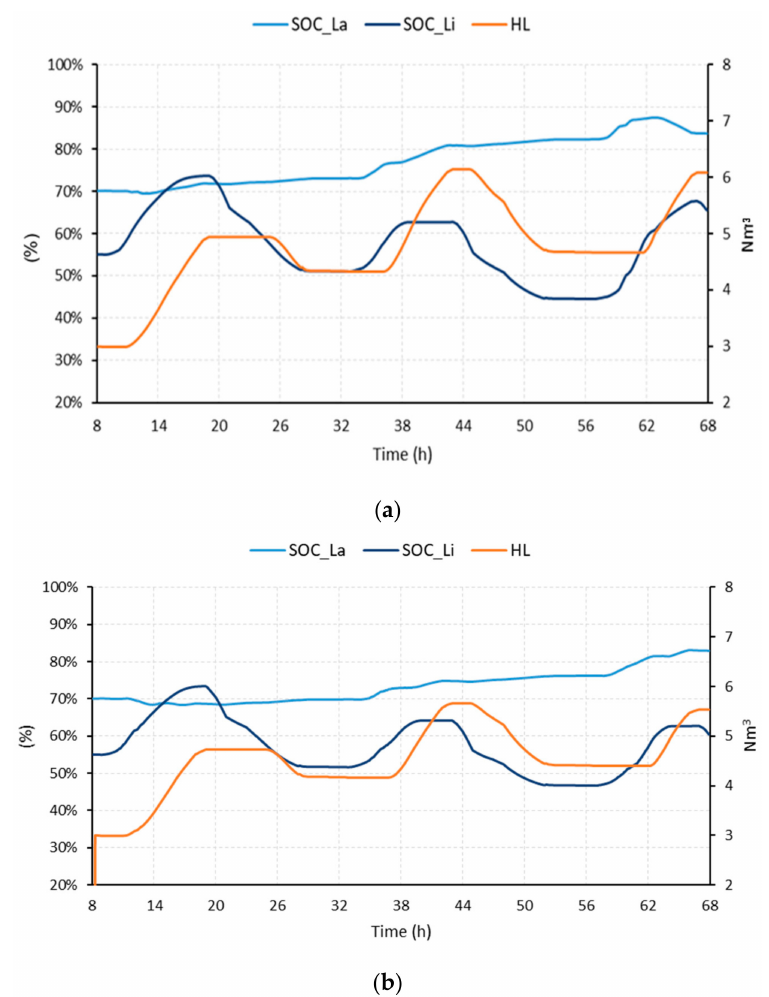
Figure 14. Lead-acid battery SOC (SOC_La), Li-ion battery SOC (SOC_Li), and hydrogen level (HL) for ( a ) stable solar profile and ( b ) fluctuating solar